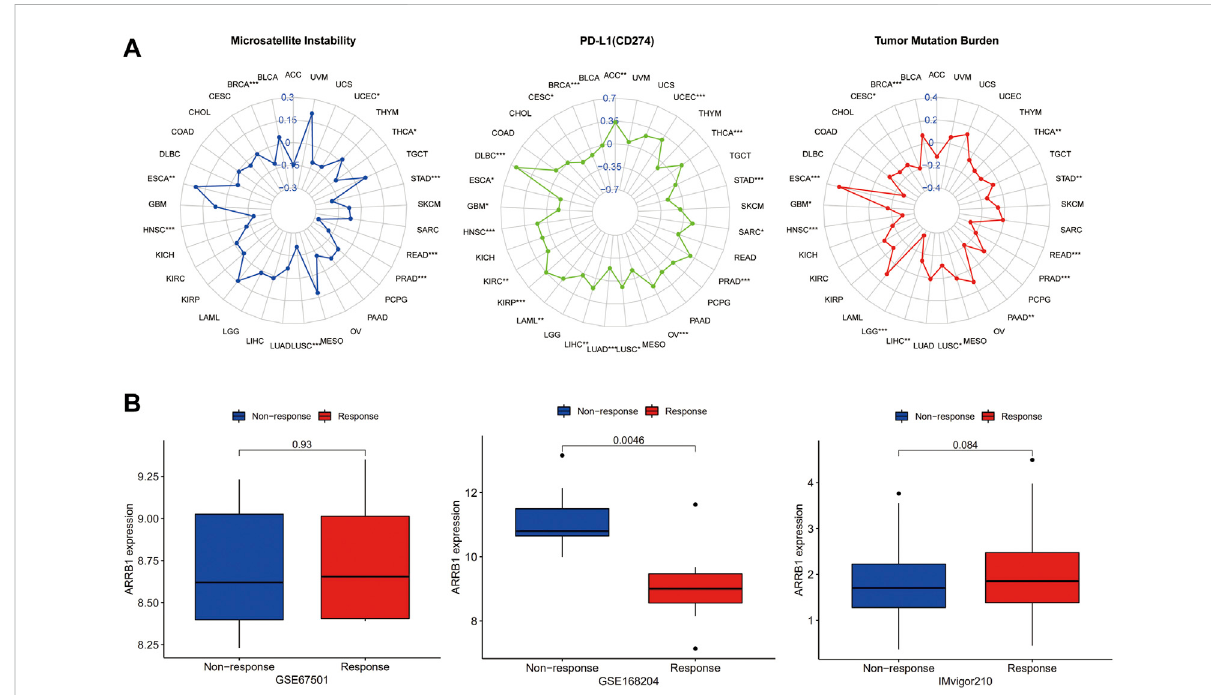
FIGURE 8 The correlation between ARRB1 expression and both predictive markers of immunotherapeutic ef fi cacy and response to immunotherapy. (A) Radar chart of the relationship between ARRB1 expression and MSI, PDL1 (CD274), and TMB. (B) Relationship between ARRB1 expression